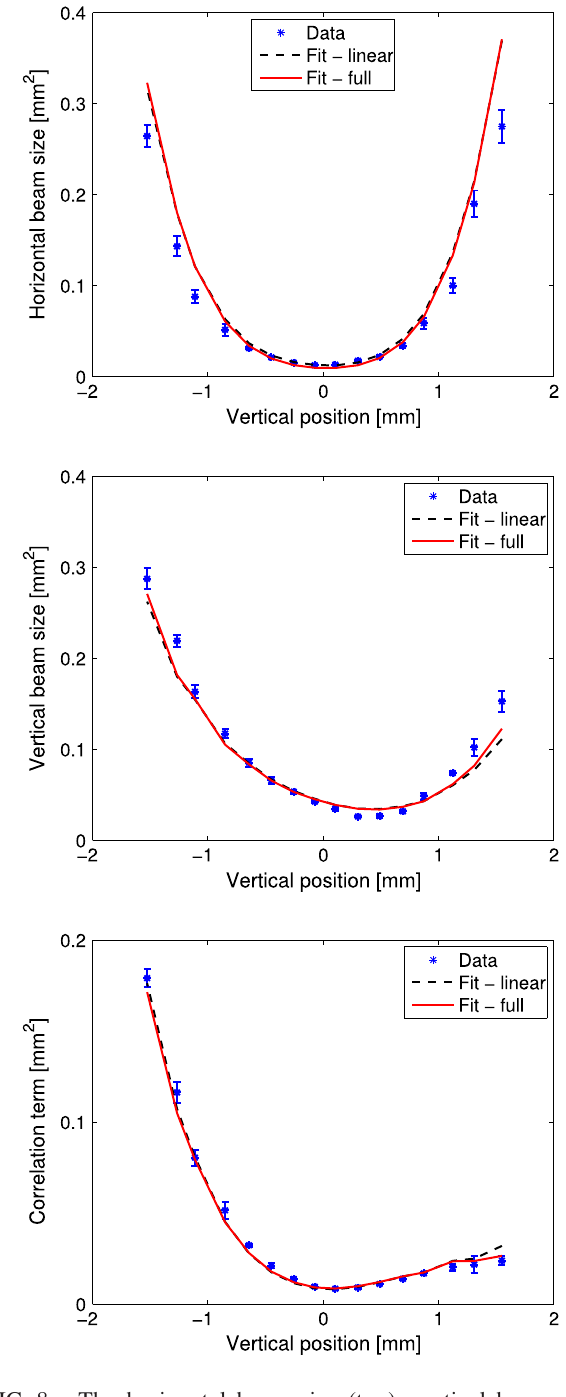
FIG. 8. The horizontal beam size (top), vertical beam size (middle) and correlation term (bottom) at different vertical positions and the fit of the linear expressions in (10) – (12) and the full analytical expressions (A11) – (A13). From the fits we retrieve the full transverse beam matrix just upstream the octupole, including all correlations. Further- more, we can see a slight improvement using the full analytical expressions.